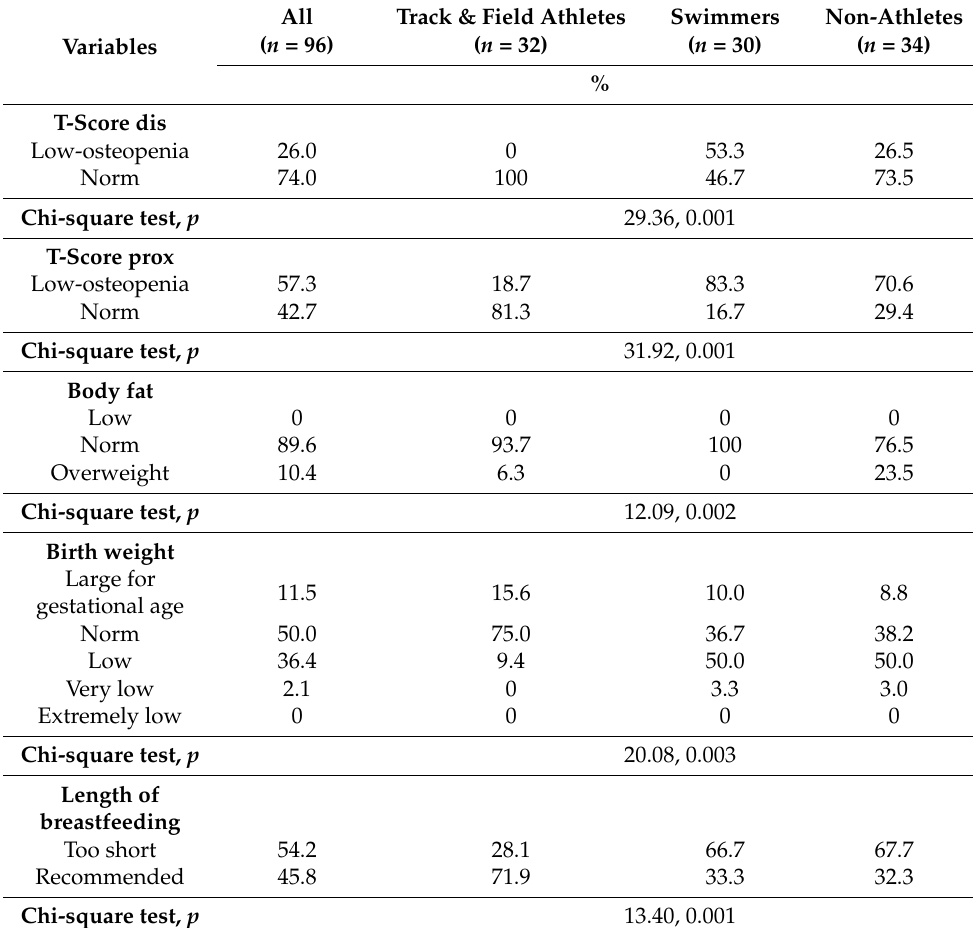
Table 2. Assessment of the incidence of low BMD (osteopenia), low fat in body, low birth weight and not recommended length of breastfeeding (results of Chi-square test, p